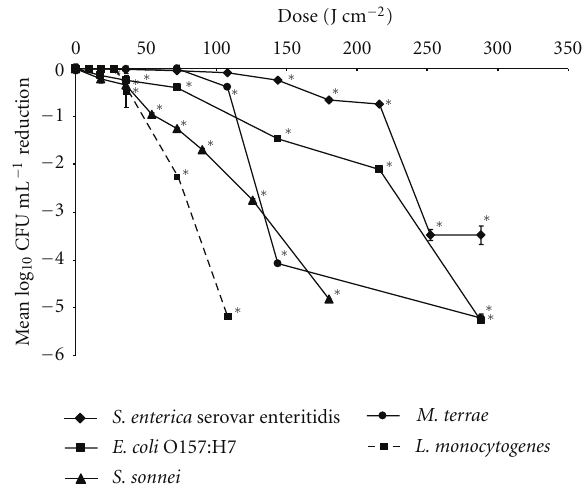
Figure 2: Inactivation of S. sonnei, E. coli, S. enterica, L. monocy- togenes, and M. terrae in liquid suspension, by exposure to high-intensity 405 nm light of an irradiance of approximately 10mWcm − 2 . Control samples remained constant throughout ex- perimentation in all cases (data not shown). ∗ Indicates where a light-exposed bacterial count was significantly di ff erent from the non-exposed control count ( P ≤ 0 . 05 calculated at the 95% confidence